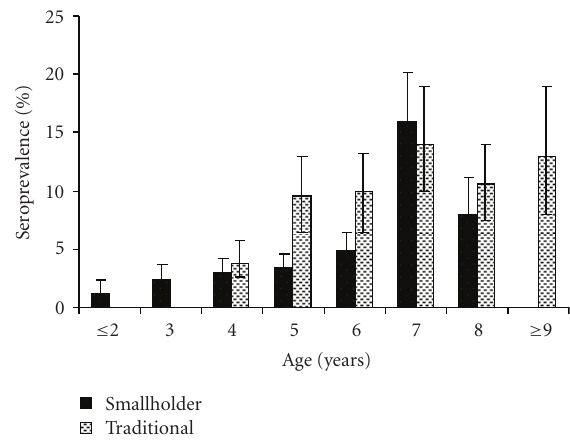
Figure 1: Age seroprevalence profile (+ / − 95% CI ) of Brucella in the smallholder dairy (black) and traditional (stippled) cattle production systems of Tanga (May 2003 − January